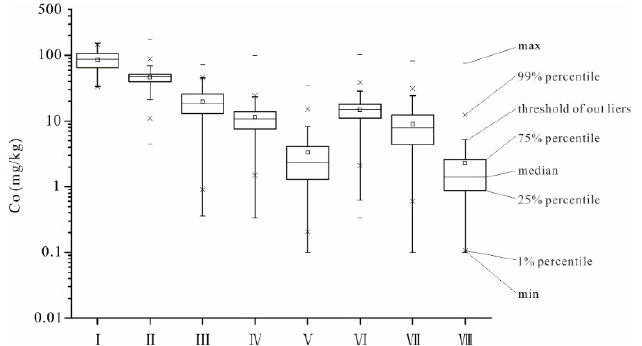
Figure 2. Box plot of cobalt content in different rock types in this paper. I: Ultrabasic rocks, II: Basic rocks, III: Intermediate Rocks, IV: Intermediate-acid rocks, V: Acidic rocks, VI: Mudstones, VII: Sandstones, VIII: Carbonates. Outliers are cases with values larger than 1.5 times the box length (interquartile range) from the lower or upper edge of the box.